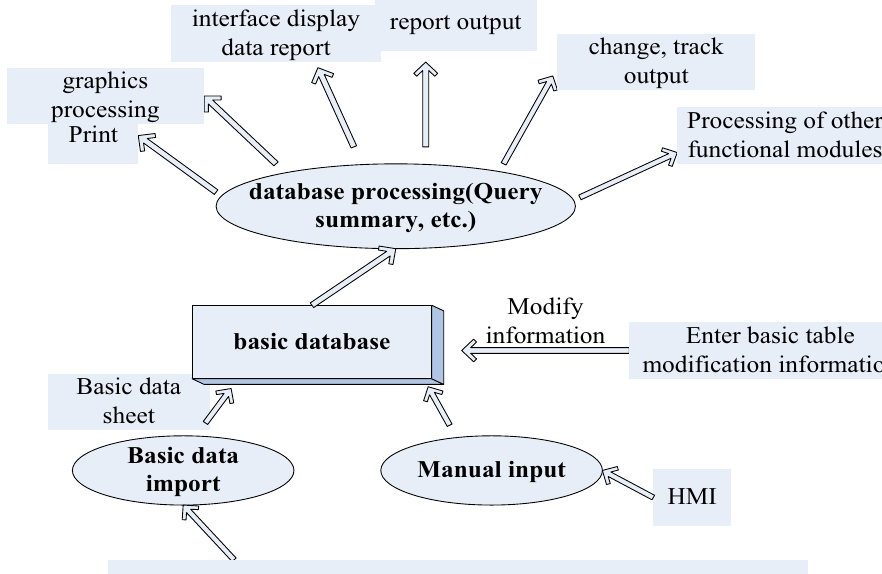
Fig. 1 Database system flow chart